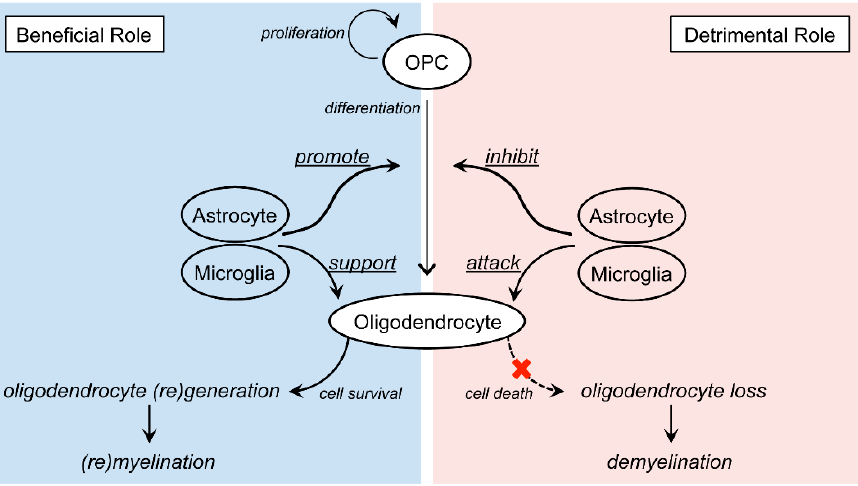
Figure 2. Schematics of the dual roles of astrocytes/microglia in oligodendrocyte damage/repair in central nervous system (CNS) diseases: In response to oligodendrocyte loss, residual oligodendrocyte precursor cells (OPCs) proliferate and differentiate into mature oligodendrocytes. Depending on the surrounding atmosphere, astrocytes and microglia exhibit both beneficial and detrimental roles towards this compensative response. A deeper understanding of their dual roles is important to develop effective therapies towards white matter-related diseases.